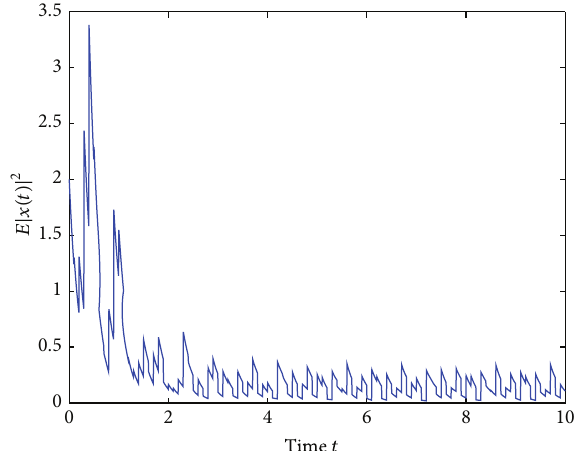
Figure 1: The mean square of the solution with external input (2000 samples).